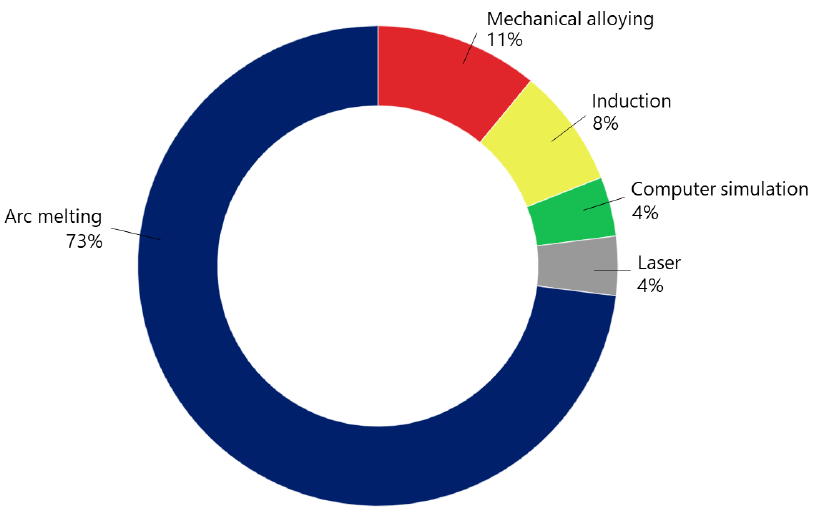
Figure 1. Percentage of bioHEAs development techniques evaluating 49 selected publications.